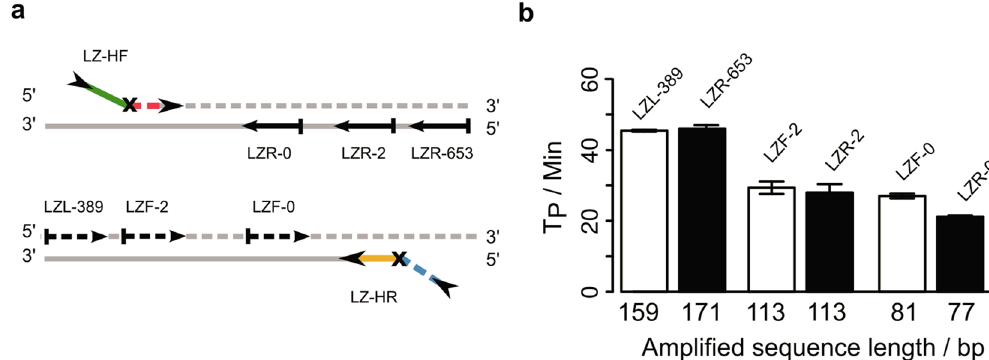
Figure 5. Analysis of the time-to-positivity values of the amplification reactions with decreasing distance of the hinge-primer to the outer primer. ( a ) Binding sites of the primers are illustrated for the Hinge-forward (LZ-HF) and Hinge-reverse (LZ-HR) primer with their respective outer primer LZL-389/LZR-653, LZF/R-2 and LZF/R- 0. ( b ) Time-to-positivity values demonstrate the relation of primer distances (length of amplified product) and amplification kinetics. Both orientations of forward hinge-primer (white bars) and the reverse hinge-primer (black bars) are shown. The experiments were carried out in triplicate and standard error bars are shown in the figure.